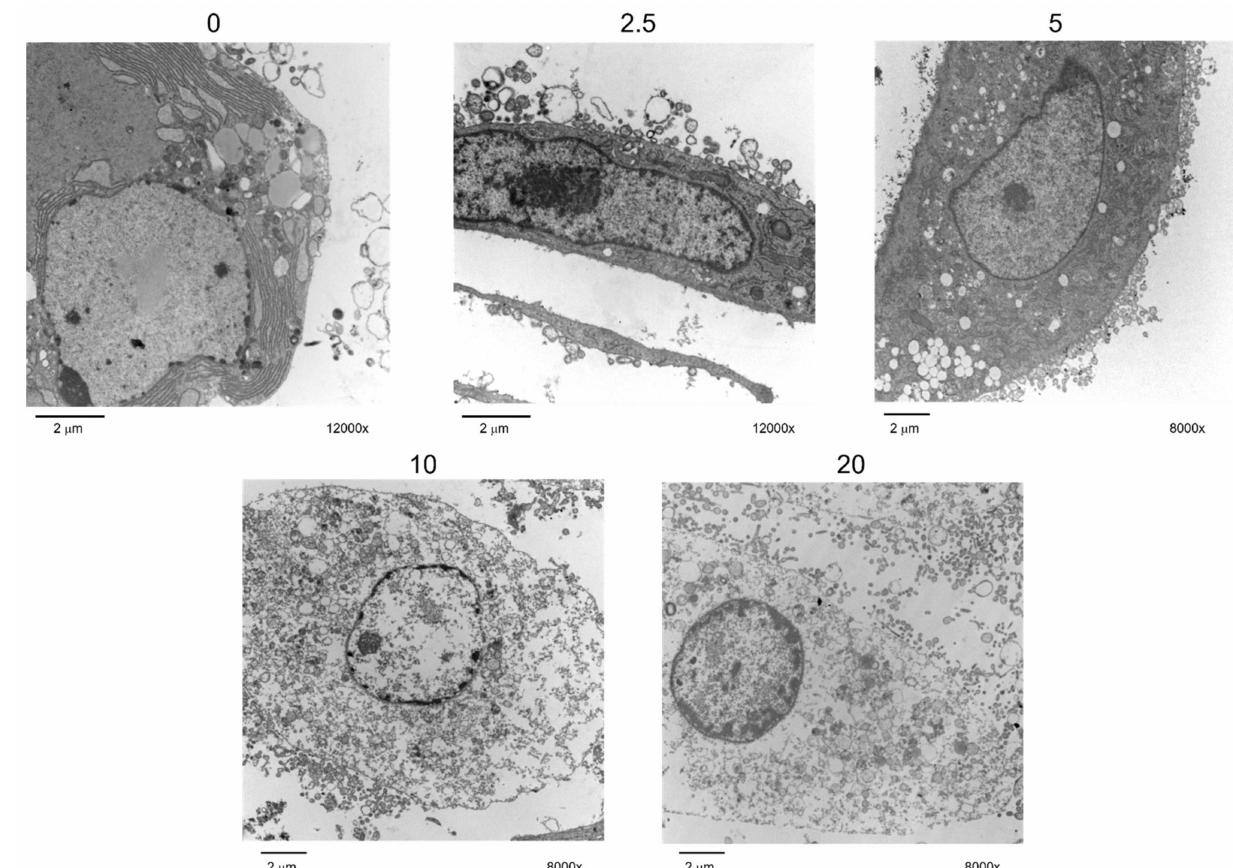
Figure 3. ZnO NP uptake by H9c2 cells. Cells (50 × 10 3 ) were cultured in 6 well plates, exposed to 0, 2.5, 5, 10, and 20 µ g/cm 2 of ZnO NPs for 24 h, and they were analyzed by TEM with a JEOL 10-10 microscope and an ATM camera system. Images are shown at a direct magnification of 8000 × and 12,000 × . Bars = 2 µ m. A representative image of three independent experiments is